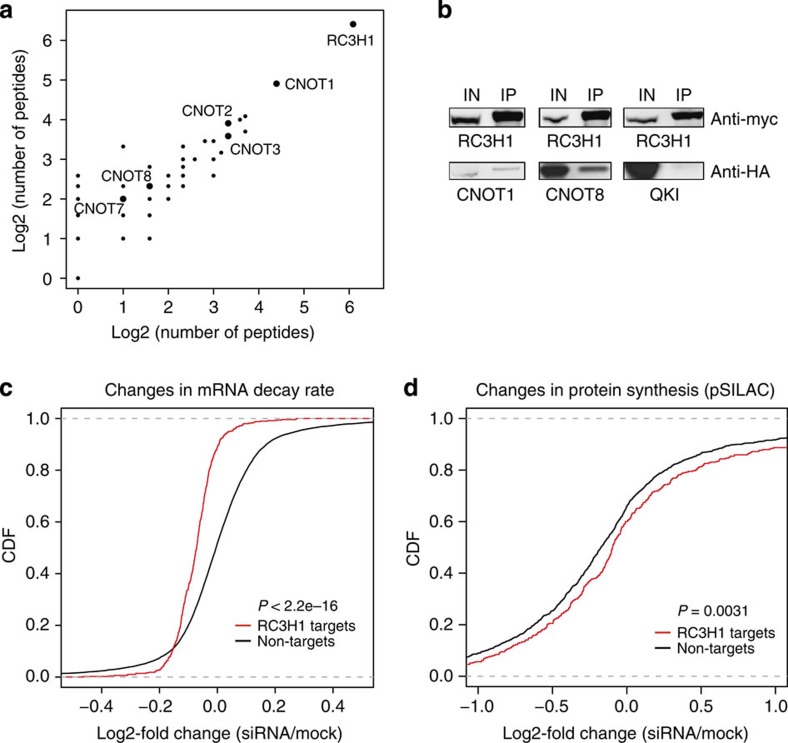
RC3H1 recruits deadenylation complex and destabilizes target mRNAs.(a) A scatter plot of identified peptide counts in two label-swap replicates. Peptides eluted from immunopurified FLAG/HA-tagged RC3H1 complex are analysed by tandem LC-MS/MS. High dose of RNaseT1/RNaseI are treated before immunoprecipitation (IP) to disrupt the indirect interactions mediated by nascent RNA. Peptides derived from the CCR4-CAF1-CNOT deadenylase complex were detected. (b) RC3H1 interactions were confirmed by co-transfection of myc-RC3H1 expression construct with HA-CNOT1, HA-CNOT8 or HA-QUAKING (QKI) expression constructs. IP was performed using anti-myc antibody. IPed proteins were resolved on SDS–PAGE, blotted and probed with anti-myc and anti-HA antibodies. Protein expression in cellular extract used as input for IP experiments is indicated (IN). (c) A cumulative distribution function (CDF) plot of log2-fold changes of mRNA decay rates of the top 500 normalized RC3H1-bound mRNAs is shown in red and all expressed mRNAs is shown in black. Top RC3H1-bound mRNAs show slower mRNA decay rates compared with all mRNAs upon RC3H1/ RC3H2 knockdown. The mean difference in mRNA decay rates (siRNA/mock) for the top 500 RC3H1 target mRNAs (n=500) and all mRNAs (n=15158) are −1.324 and −0.074, respectively (P value <2.2e–16, Wilcoxon's rank sum test). (d) A CDF plot of log2-fold changes of protein synthesis of consensus RC3H1 target transcripts that have >100 transitions on 3′UTR is shown in red and non-targets is shown in black after siRNA-mediated RC3H1 depletion. Protein synthesis of RC3H1-bound mRNAs was upregulated upon RC3H1 knockdown (P value 0.0031, Wilcoxon's rank sum test). The mean log2-fold changes for RC3H1 targets (n=390) and non-targets (n=1,279) are 0.001 and −0.116, respectively.